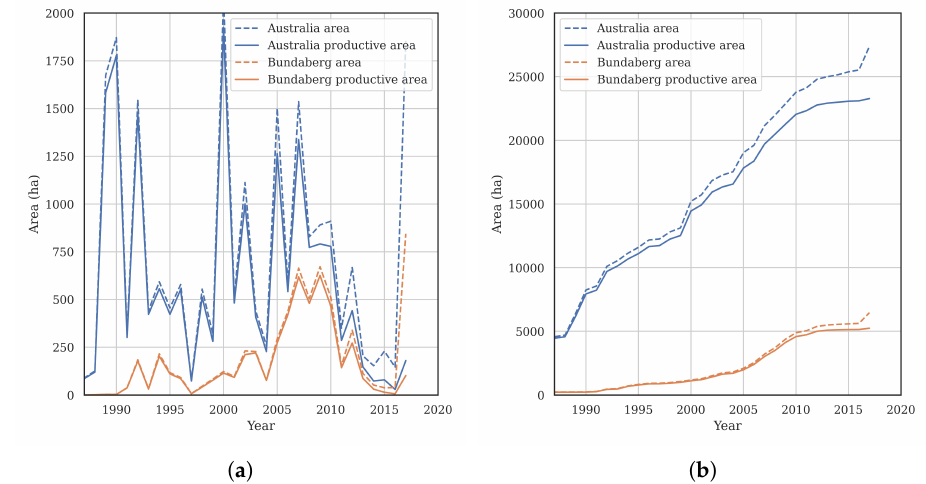
Figure 7. Estimates of macadamia area in all Australia and just the Bundaberg region, both with and without the productive area mask applied. ( a ) Planted per year and ( b ) cumulative